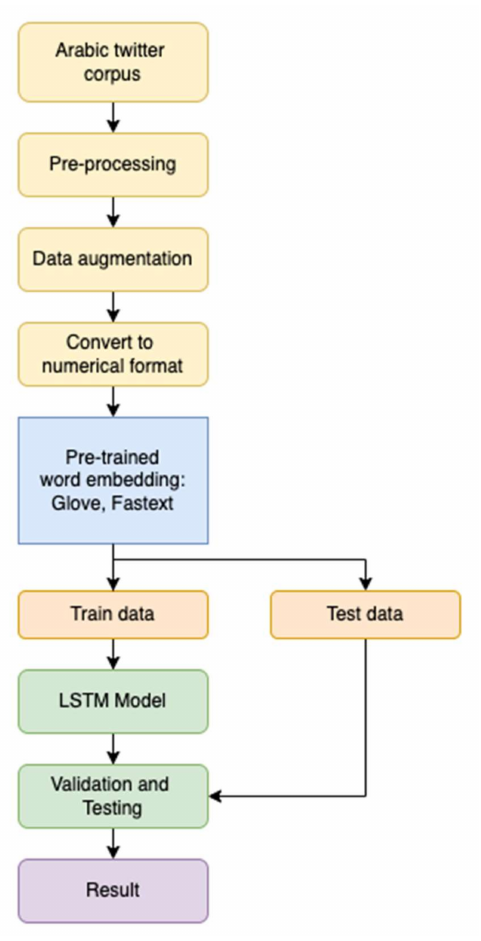
Figure 1. Proposed framework for Arabic text